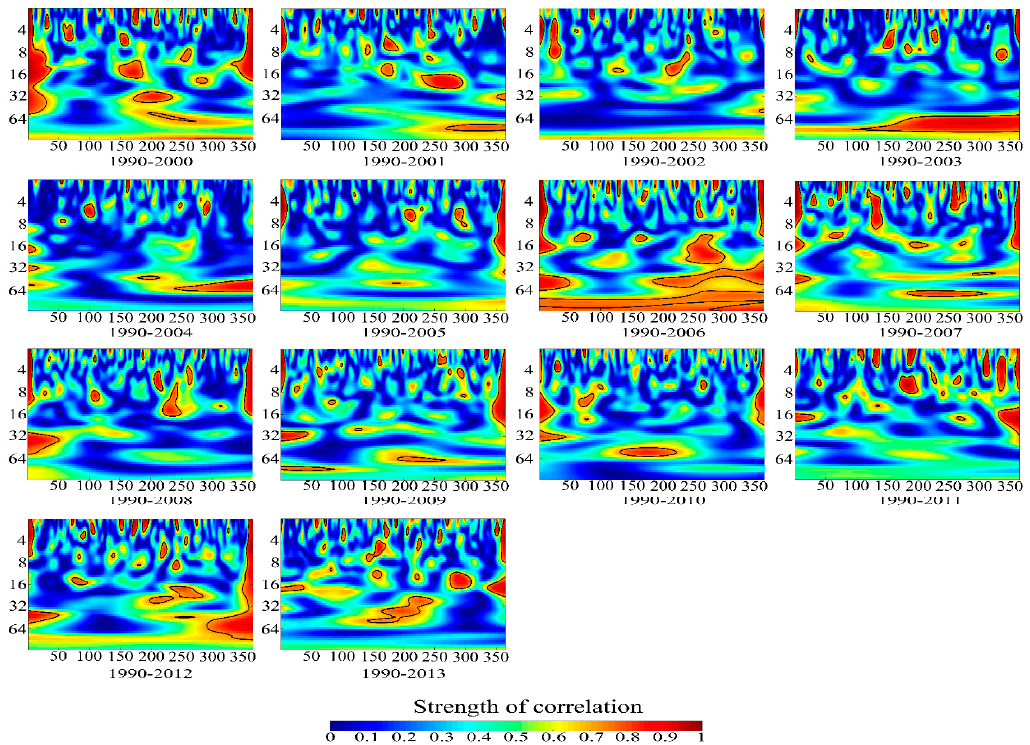
Figure 4. The correlations and similarities of precipitation patterns in the target year, 1990, and reference years from 2000 to 2013. The X-axis indicated the period along the whole year; the Y-axis indicated the temporal scales; the 95% confidence levels were shown as the thick solid lines; the color bar indicated the strength of correlation.